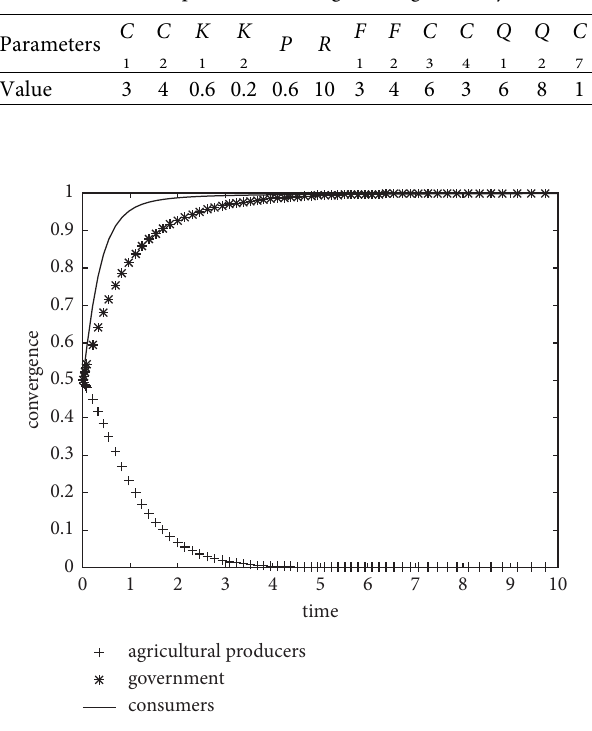
Figure 7: Tripartite evolutionary stabilization strategy diagram.